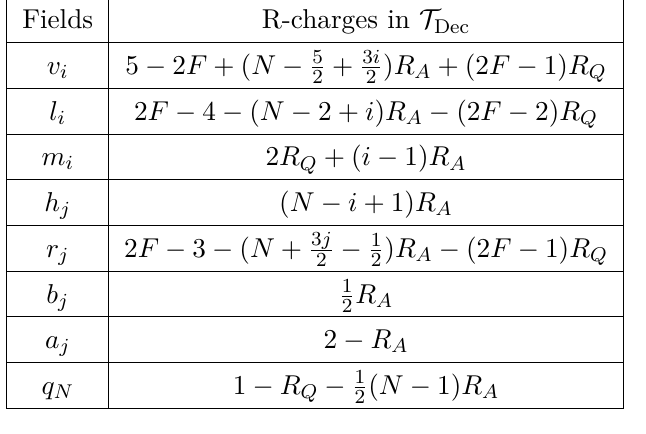
Table 2 . R-charges in T Dec with i = 1 , . . . , N and j = 1 , . . . , N − 1